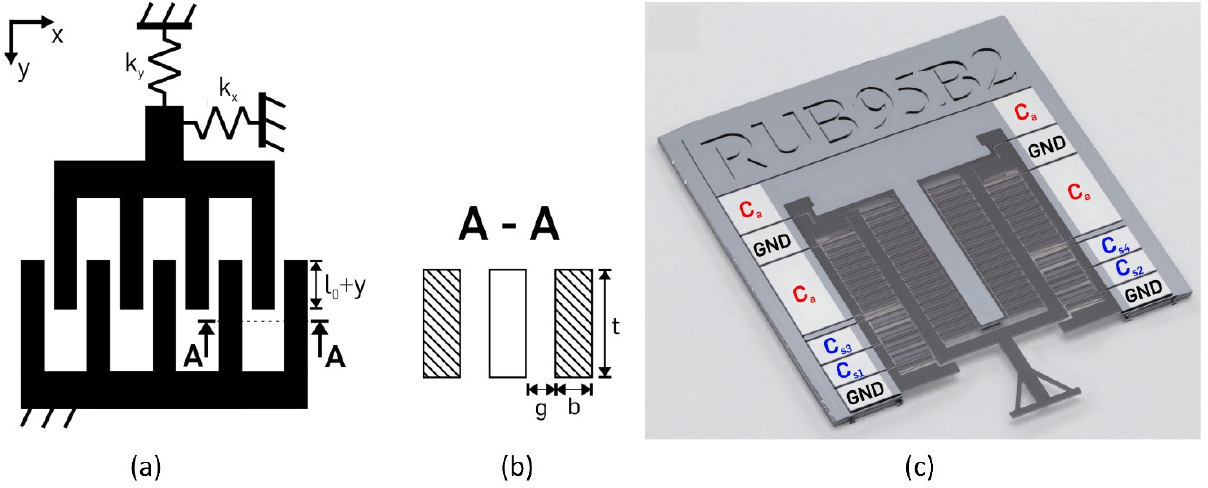
Figure 12. A single-sided electrostatic comb-drive actuator. ( a ) Schematic view, l 0 —finger overlap, y—displacement in y direction, k x , k y —spring stiffness in x and y directions; ( b ) a cross-section of the finger electrodes with finger gap g, width b, and depth t; ( c ) final processed constant-force microchip with electronic connections. Adapted from [90].